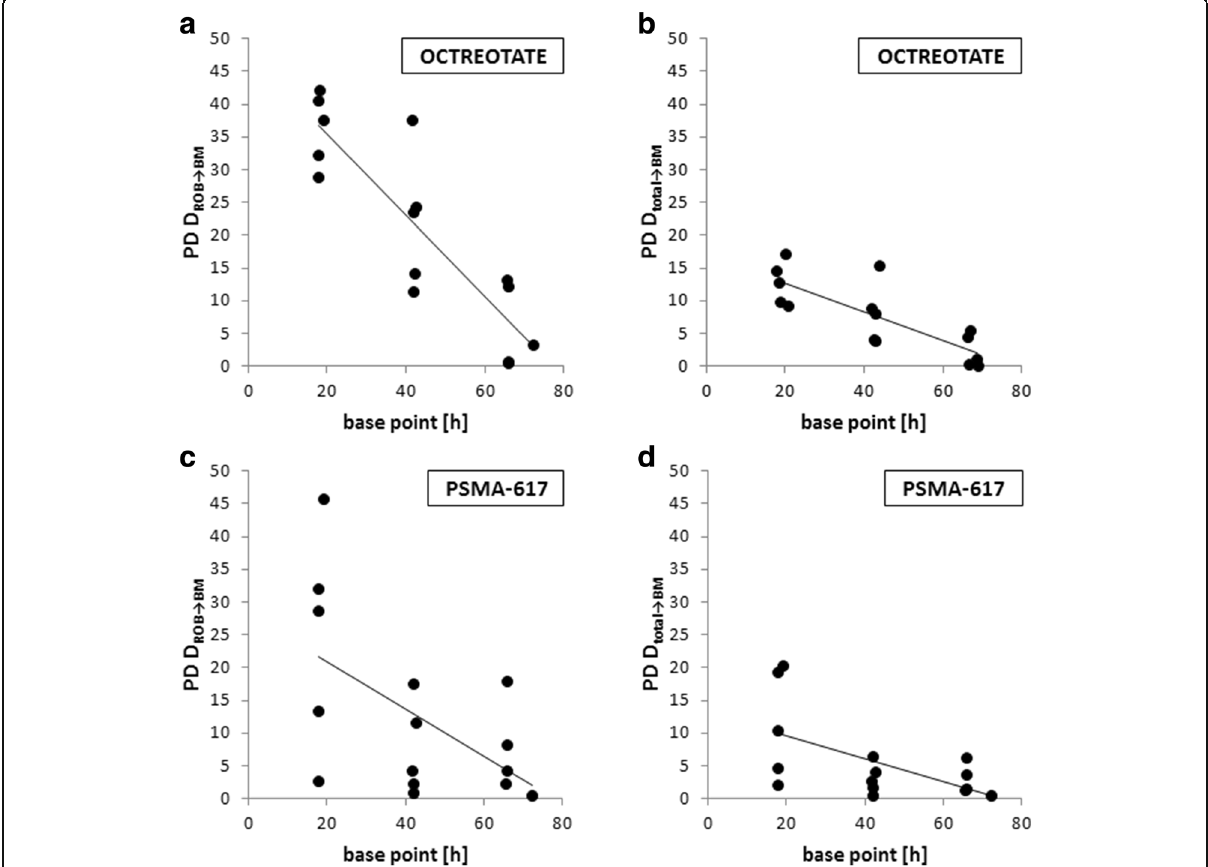
Fig. 4 Percentage deviation (PD) from the reference protocol for the bone marrow absorbed dose from the ROB and the total bone marrow absorbed dose depending on the base point used for the hybrid protocol (24, 48, or 72 h p. i.). All percentage deviations were calculated according to Eq.